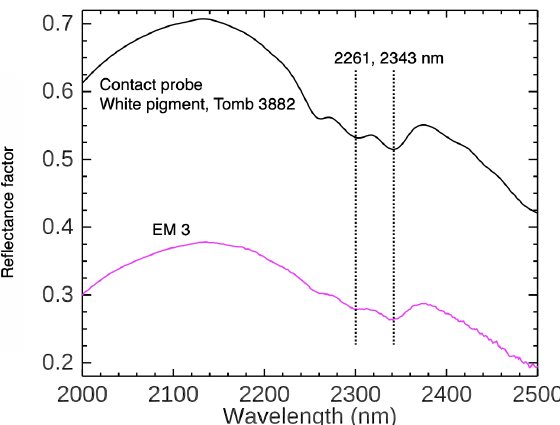
Figure 7. Comparison of the SWIR spectral ranges (2000 to 2500 nm) of EM 3, a mixture of red ochre and CaCO 3 , and a FORS measurement of a white pigment from a painted geometric design on another wall painting in Tomb